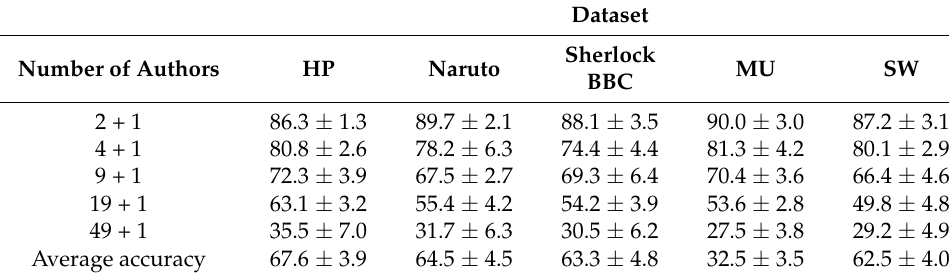
Table 17. Method based on cosine similarity thresholding for in-group